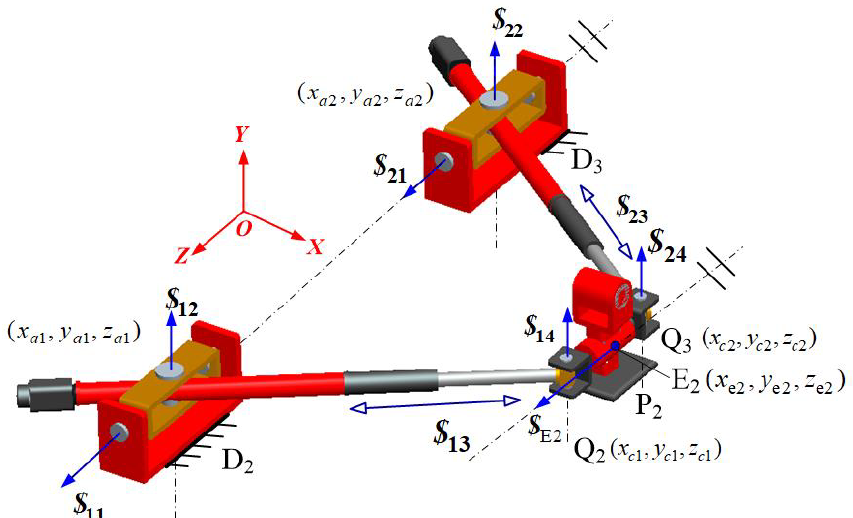
Figure 4. Single Loop